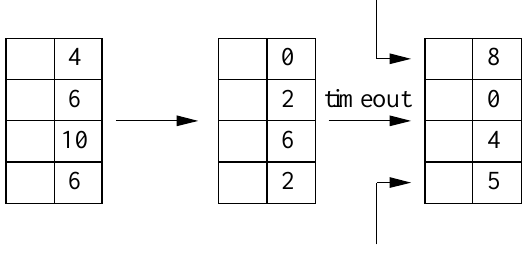
Figure 2. Expiration of